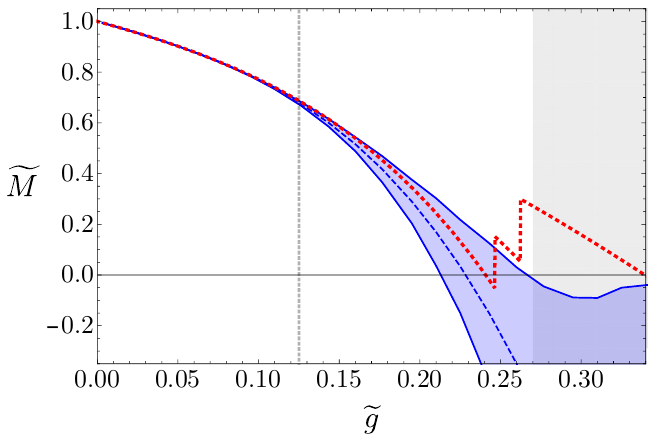
Figure 9 . The physical mass M as a function of the coupling constant branch using the coe(cid:14)cients up to the g 4 order. We compare the Borel resummation result using f conformal mapping (blue dashed line) with optimal truncation (red dotted line). The vertical dotted line at g = g 0 : 125 is the coupling (taken from ref. [11]) where the mass of the elementary e k (cid:22) k (cid:25) particle is twice the mass of the kink and might become e e